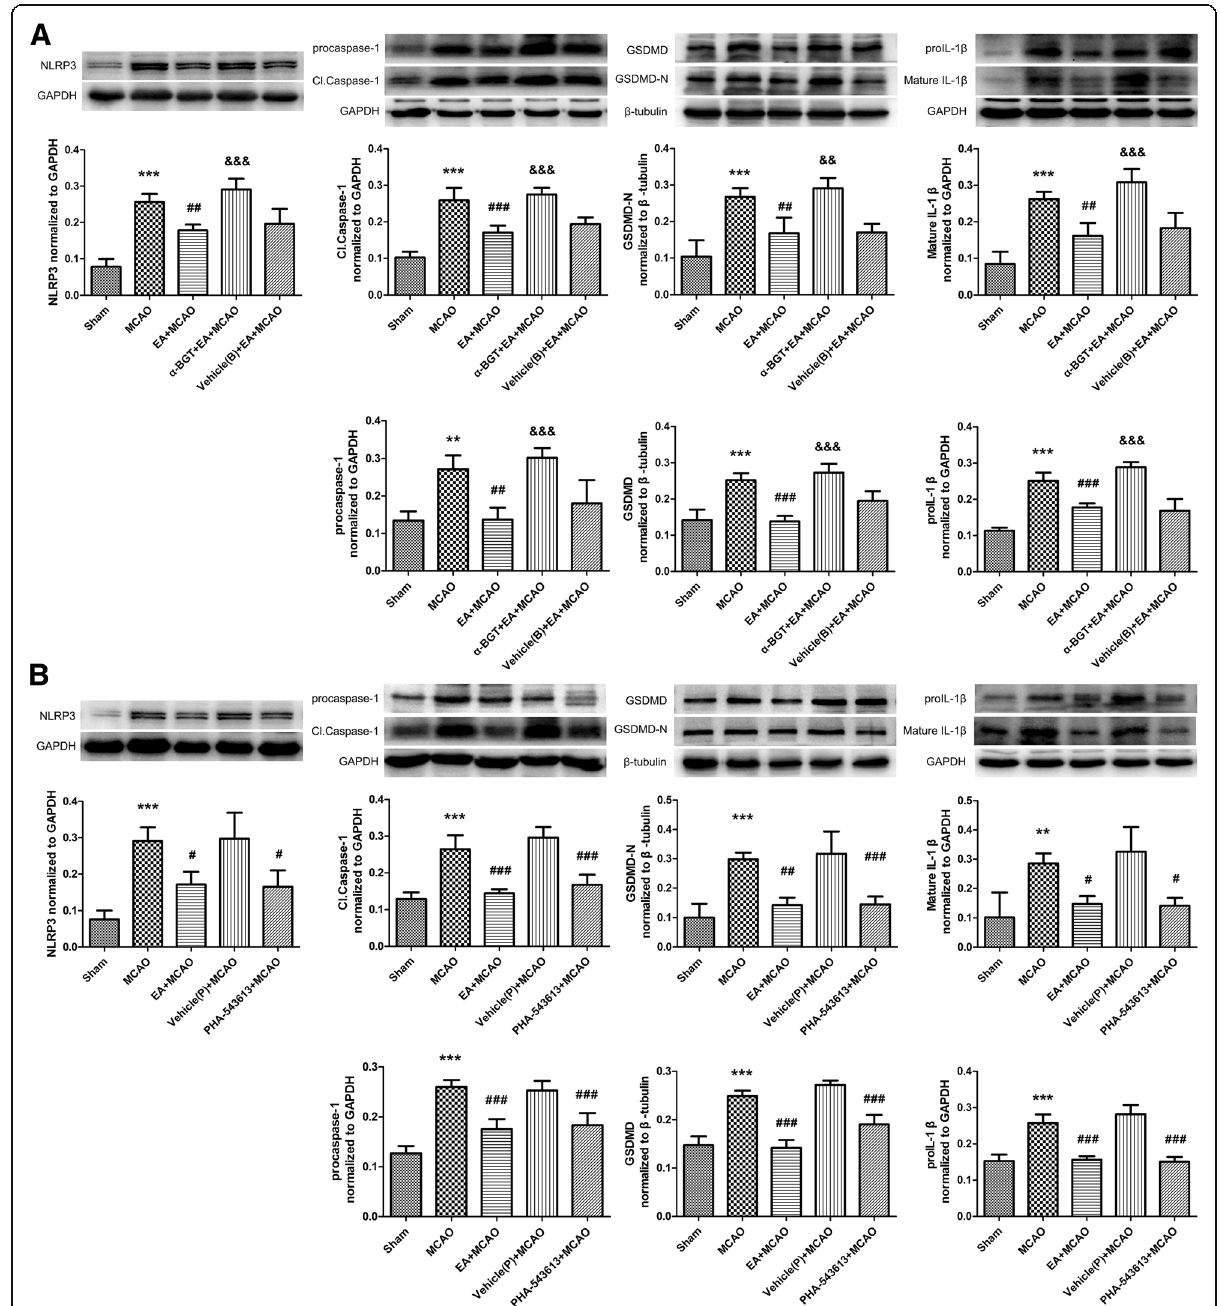
inflammasome by EA stimulus. Representative western immunoblotting analysis of NLRP3, Caspase-1, GSDMD and IL-1 β ( n =4). Compared with EA+ MCAO group, the expression of NLRP3, procaspase-1, Cl.Caspase-1, GSDMD, GSDMD-N, proIL-1 β and mature IL-1 β were increased in α -BGT+EA+MCAO group. ** P <0.01, *** P <0.001 vs. Sham group, ## P <0.01, ### P <0.001 vs. MCAO group, && P <0.01, &&& P <0.001 vs. EA+MCAO group. b α 7nAChR agonist mimicked the inhibition of NLRP3 inflammasome by EA stimulus. Representative western immunoblotting analysis of NLRP3, Caspase-1, GSDMD and IL-1 β ( n =4). Comparison with MCAO groups showed that intraperitoneal injection of PHA-543,613 down-regulated the levels of NLRP3,